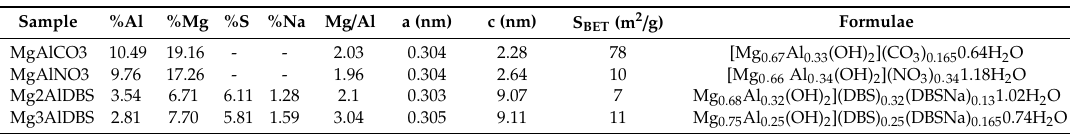
Table 1. Elemental analysis results and some structural data for the MgAlCO3, MgAlNO3, Mg2AlDBS and Mg3AlDBS samples.